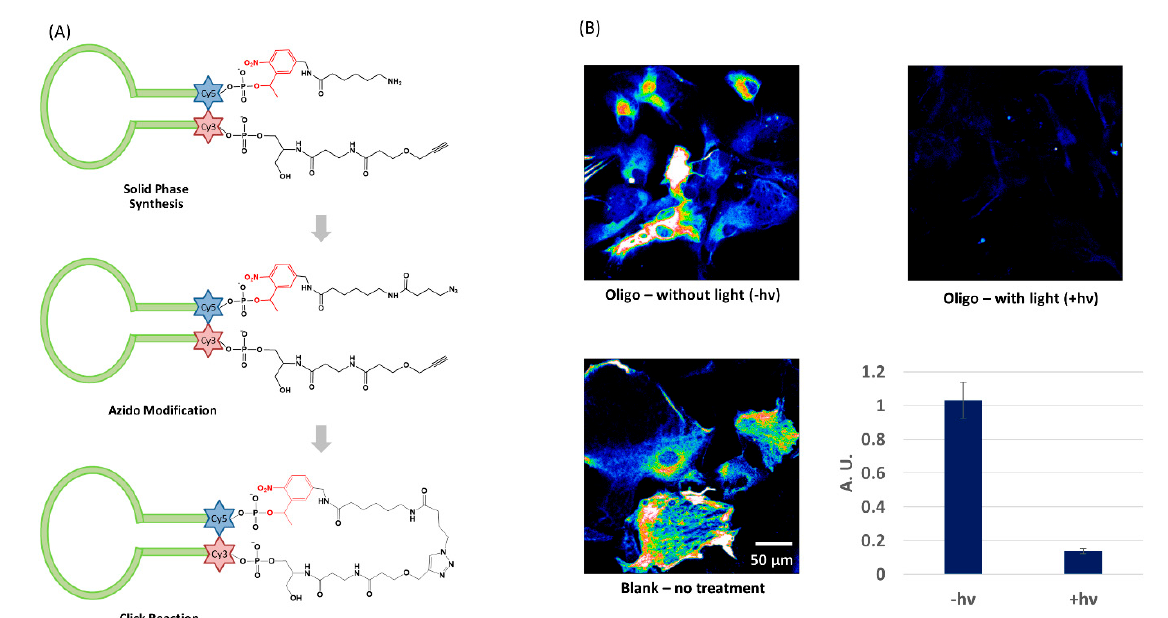
Figure 2. Circular caged oligo for gene expression regulation: ( A ) 3-step synthesis to make circular caged oligo; ( B ) Immunofluorescence for selectively imaging GFAP for samples loaded with AS-ODN, with or without light irradiation, and blank sample without any treatment. Quantification was conducted with average pixel intensity in individual cells normalized to the blank sample. Adapted from ref [85]. The figure is adapted with permission from: Yang, L. et al. ChemBioChem 2018, 19, 1250–1254. Copyright 2018 Wiley-VCH Verlag GmbH & Co. KGaA, Weinheim.